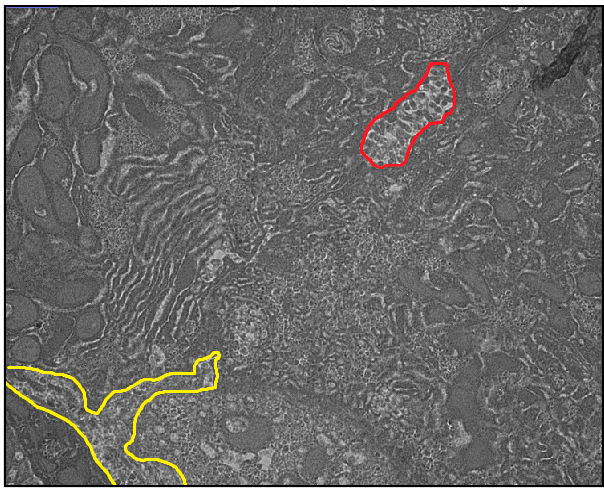
Figure 1. Illustrates an example of mapping using ultrathin sections of transmission electron microscopy (TEM). Red line surrounds the canalicular space, and the yellow lines are around the area of Disse. The ImageJ software uses these boundaries to calculate morphometric parameters automatically.